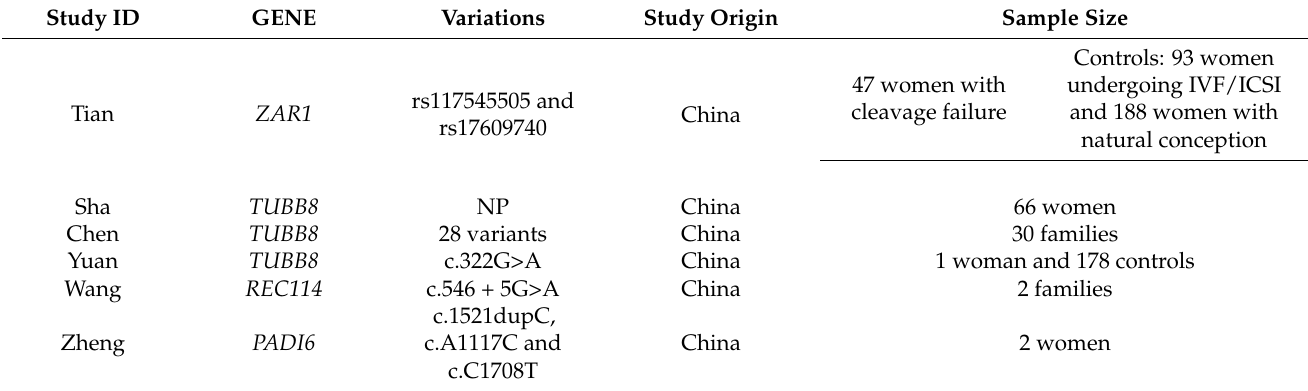
Table 1. Characteristics of the studies on the effect of maternal gene variations on developmental arrest. Study